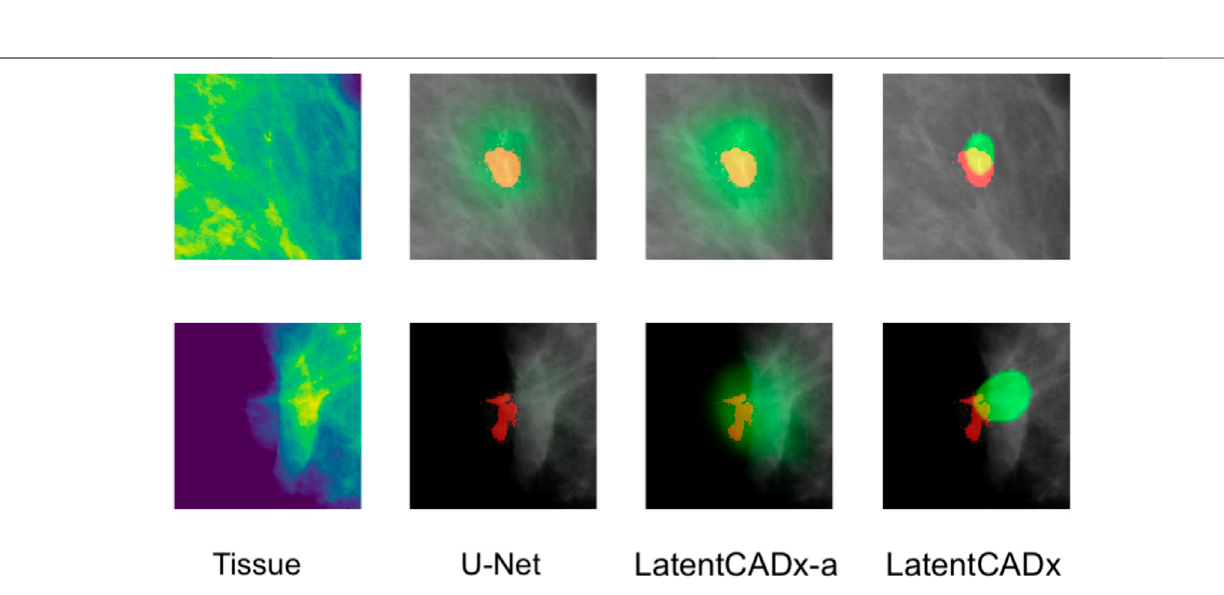
Frontiers in Big Data |